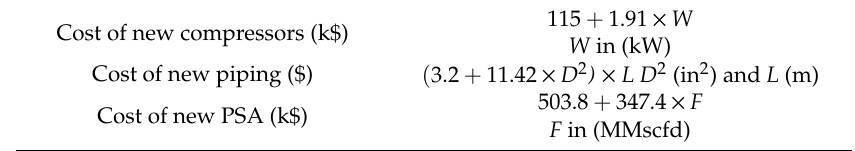
Table 2. Parameters used to calculate the capital cost